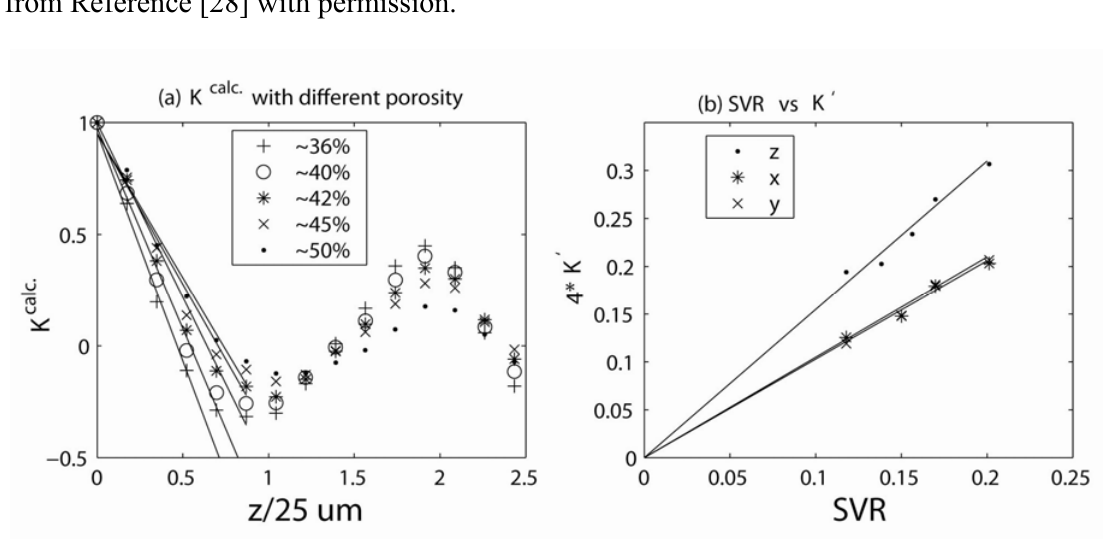
Figure 13. ( a ) Numerically evaluated pair correlation functions of the internal fields with varying porosity; ( b ) Linear relationship between the initial slope of the pair correlation function and surface-to-volume ratio obtained by the porosity of the pack [68]. Reproduced from Reference [28] with